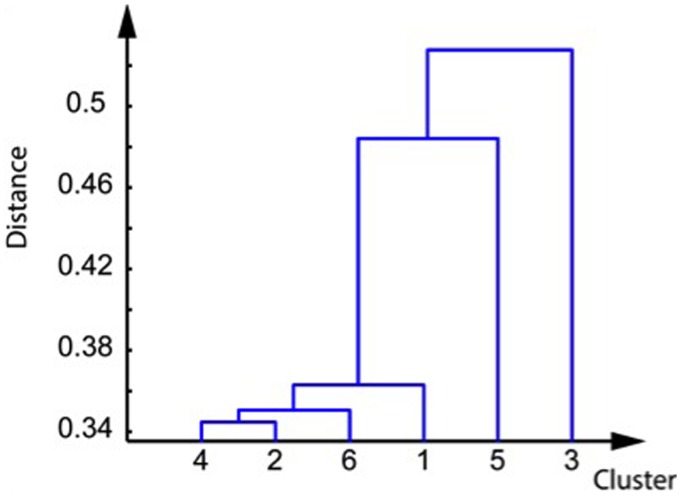
Dendrogram of the clusters, computed from their cosine distance matrices.